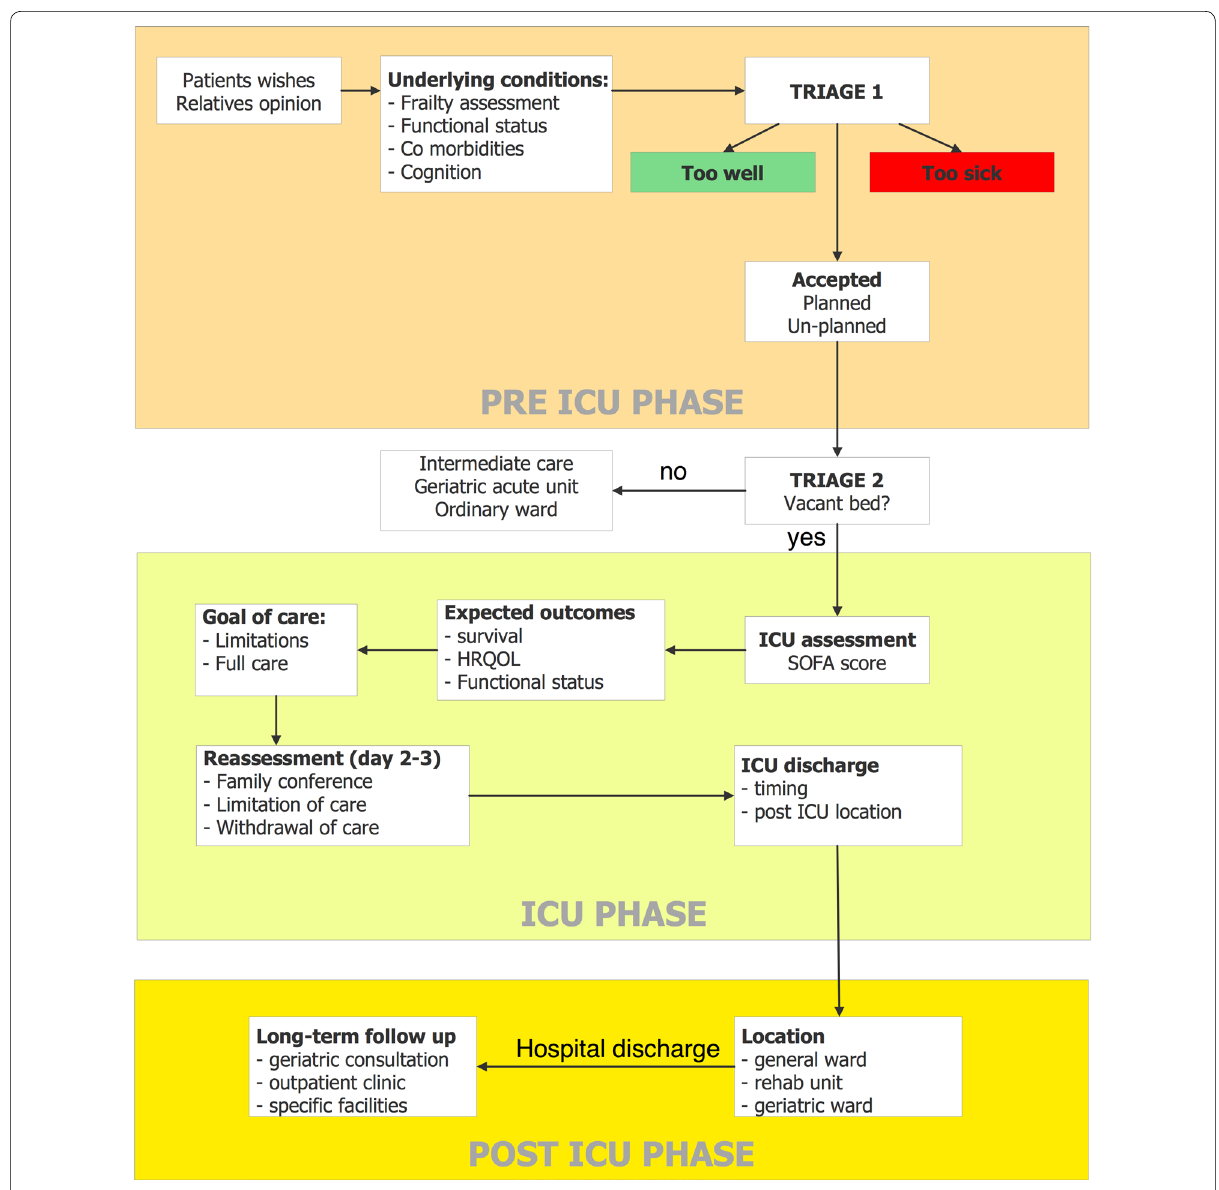
Fig. 1 Algorithm for critically ill patients over